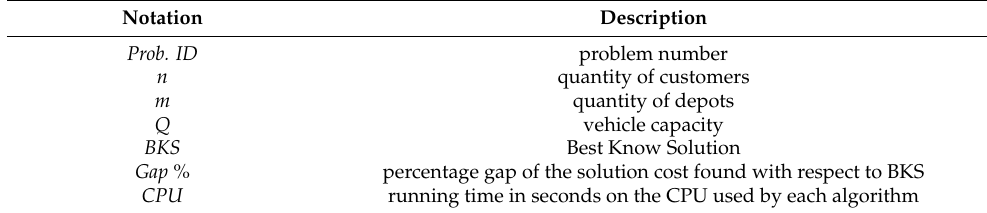
Table 1. Notation for CLRP instance.